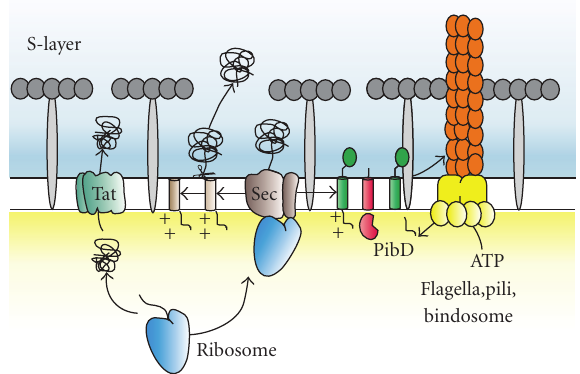
Figure 1: Model of the archaeal cell envelope showing di ff erent characterized secretion pathways. Proteins synthesized at the ribo- some can follow several routes to the exterior of the cell. During co- translational translocation, the ribosome-nascent chain complex is targeted to the SecYE β complex by the signal recognition particle. At the SecYE β complex protein synthesis and translocation across the cytoplasm membrane occurs simultaneously. In the case of a preprotein with a class I signal peptide, the signal peptide is removed during translocation and the protein is released and folds at the external face of the membrane. Class III signal peptide containing proteins translocated via the SecYE β complex are pro- cessed by PibD and subsequently assembled into a flagellum, pilus, bindosome or so far unknown cell surface structures. Alternatively, folded proteins are transported across the cytoplasmic membrane via the Twin arginine translocase